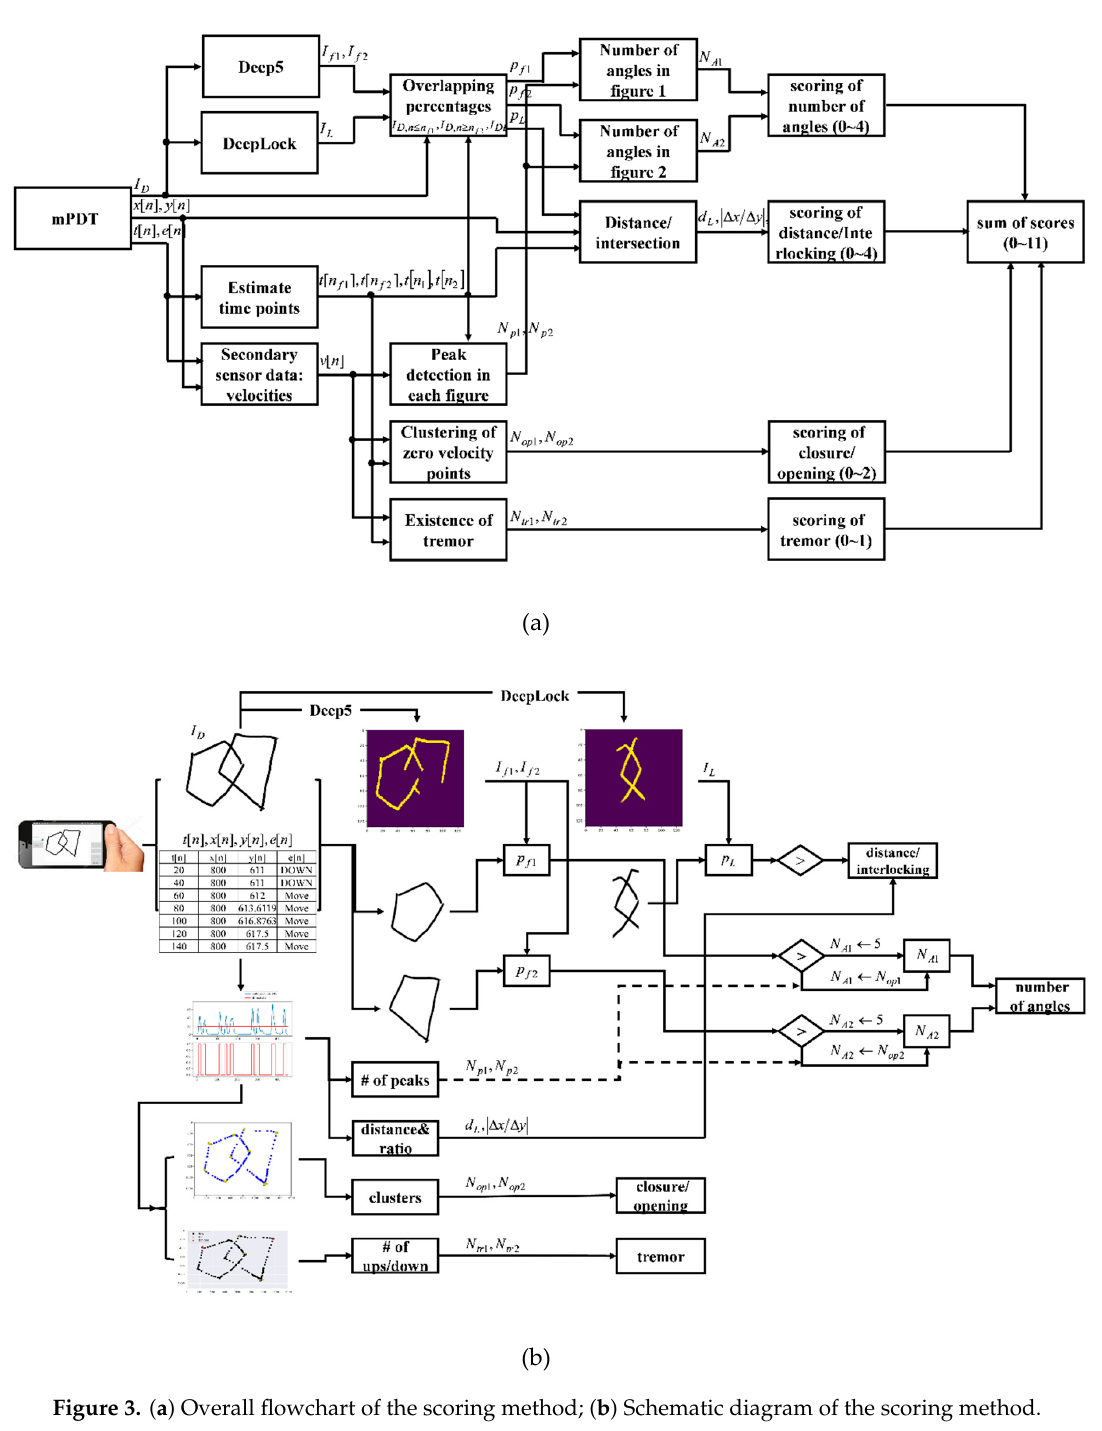
Figure 3. ( a ) Overall flowchart of the scoring method; ( b ) Schematic diagram of the scoring Figure 3. (a) Overall flowchart of the scoring method; (b) Schematic diagram of the scoring method.